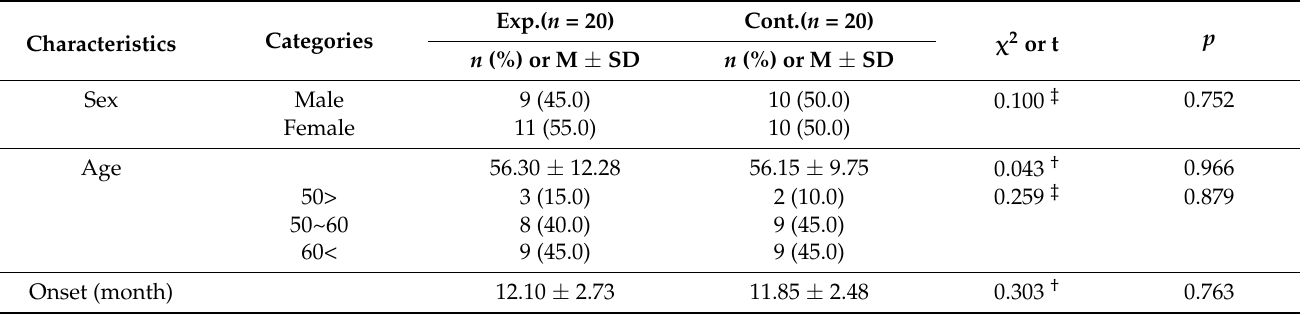
Table 1. Characteristics of the subjects.